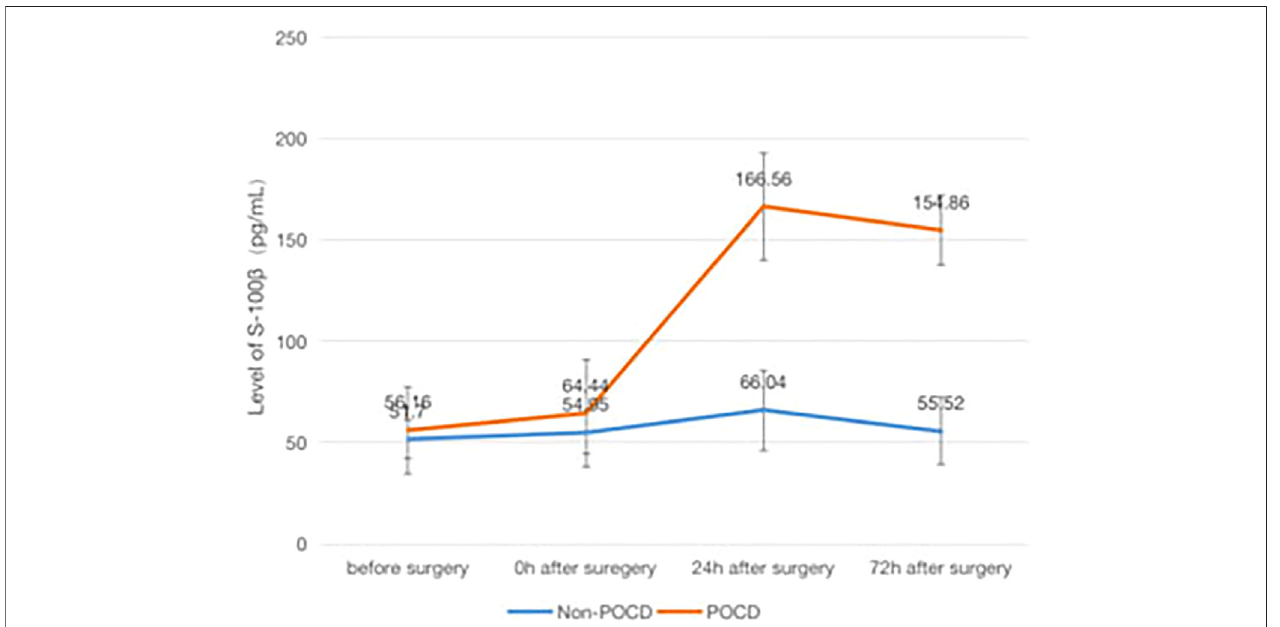
FIGURE 1 | Comparison of serum concentrations of S-100 β (pg/ml) between non-POCD and POCD groups before and after surgery 丨 There was no signi fi cant difference in the preoperative levels of S-100 β concentration in the Non-POCD group compared with postoperative levels. There was no signi fi cant difference in the preoperativelevelsofS-100 β concentrationintheNon-POCDgroupcomparedwithPOCDgroup.Comparedwithpreoperativelevels,thelevelsat24thand72ndhours after surgeries in the POCD group increased with statistically signi fi cance. The differencesin the levels of S-100 β concentration between patientsin the POCD and Non-POCD groups at the same time points postoperatively were statistically signi fi cant. Values are mean ± SD. n (cid:1) 61. * p < 0.05 vs. the preoperative level of S-100 β ; # p < 0.05 vs. the POCD